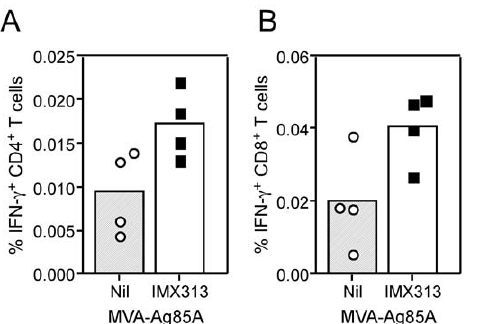
Figure 6. T cell responses in the draining auricular draining lymph node three days after vaccination with 10 6 PFU MVA- Ag85A. Graphs represent the frequency of IFN- c + CD4 + T cells ( A ) or CD8 + T cells ( B ) after 6 hours of restimulation with the total antigen 85A peptide pool and staining for a variety of surface activation markers (S4). Data were log transformed and analyzed with a 2-way analysis of variance; a significant effect of IMX313 fusion was only observed for the frequency of antigen 85A specific cells p=0.0101 but not for any surface marker (Figure S3).